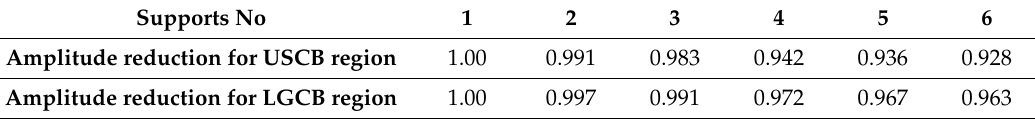
Table 3. Reduction factors of the amplitude accelerations for the consecutive supports of the viaduct in the USCB and the LGCB regions.